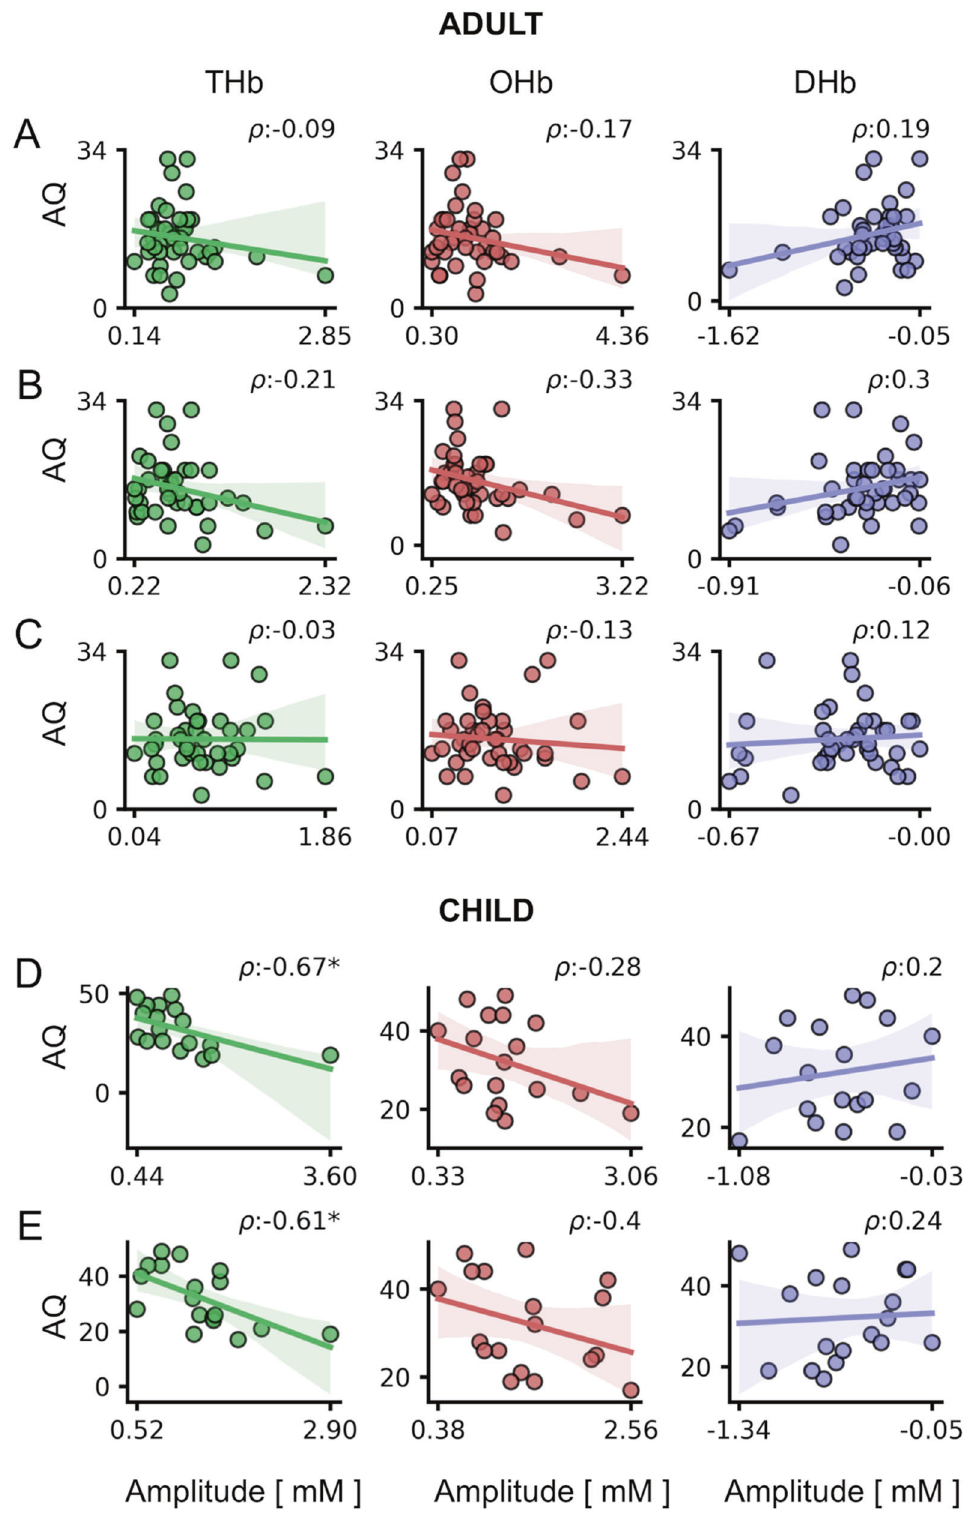
Fig. 4 Correlation between HDR and AQ scores. For all panels, values in the x -axis are multiplied for 10^4. The ρ (rho) index in each plot indicates the Spearman correlation value. Correlation between HDR and AQ scores in adults, for amplitudes obtained using RS ( A ), CF ( B ), and CC ( C ). No signi fi cant correlations were detected for adult participants. Correlation between HDR and AQ scores in children, for amplitudes obtained using high ( D ), and low ( E ) contrast baseline cartoons. A signi fi cant correlation was found between THb and AQ scores for both high- and low-contrast blended stimuli ( p < 0.05 for both cases). Circles are individual values; lines represent the linear regression model fi t and shaded regions are the 95%